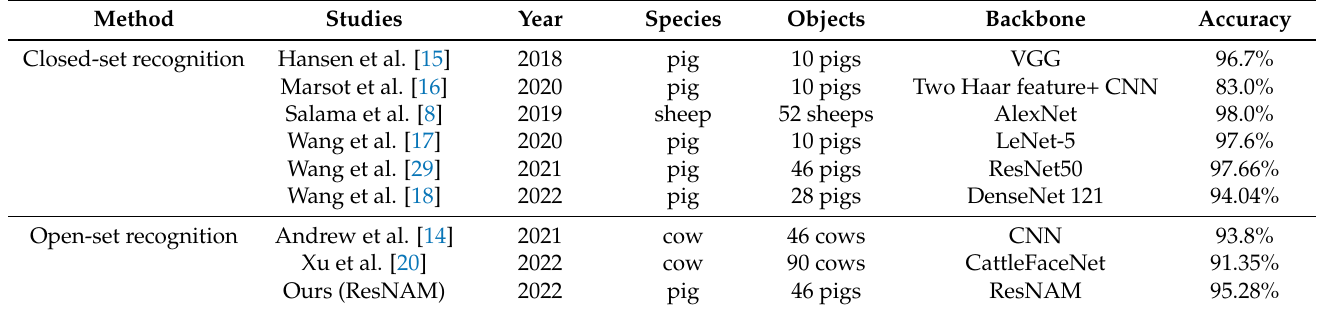
Table 8. Results of a comparison of individual recognition methods for